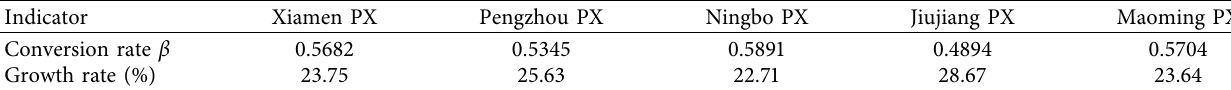
Table 5: Conversion rate β of the silent to the disseminator after PX project is stigmatized.